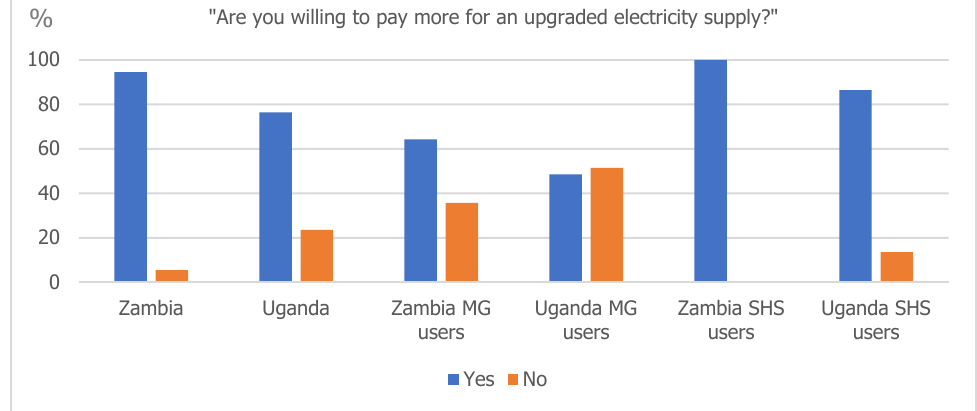
Figure 8. Willingness to pay for an upgraded connection, Energy-use demands, Consumer Groups in Uganda and Zambia (Responses in %; multiple responses; N = 1037).